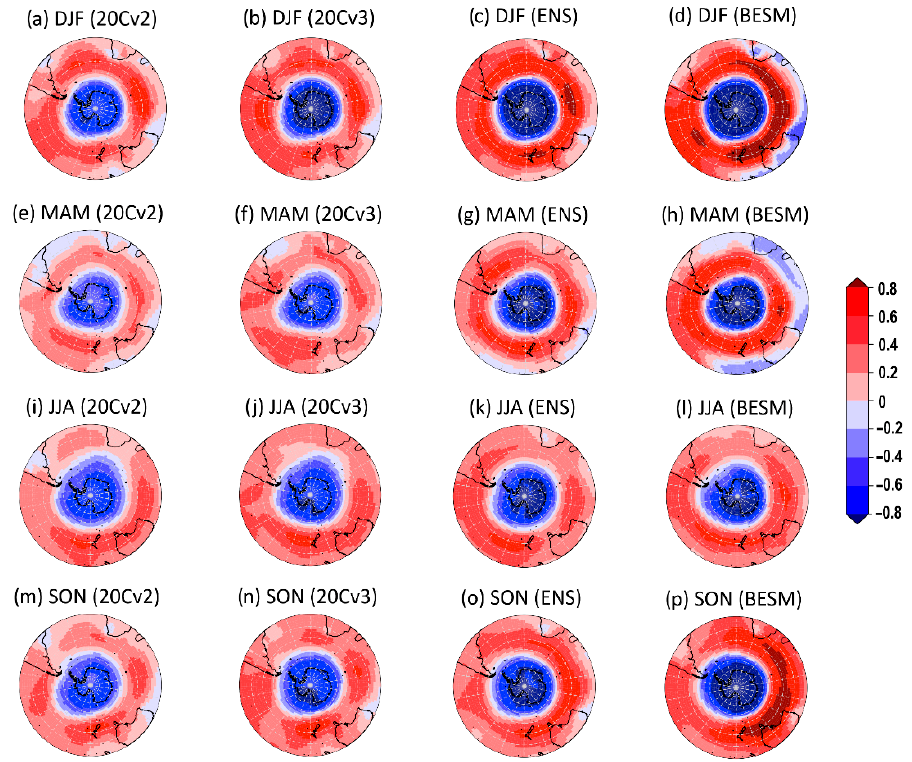
Figure 3. SAM GW99 index correlation with seasonal SLP anomalies. DJF: ( a – d ); MAM: ( e – h ); JJA: ( i – l ); SON: ( m – p ). First column: NOAA-20Cv2 reanalysis; second column: NOAA-20Cv3 reanalysis; third column: CMIP5 ensemble mean; and fourth column: BESM. Reference period: 1871–2005.